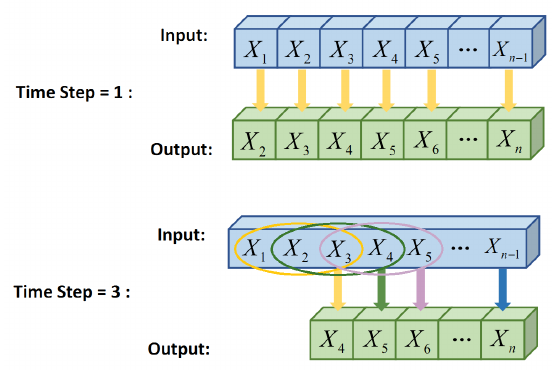
Figure 4. Time step working mechanism.